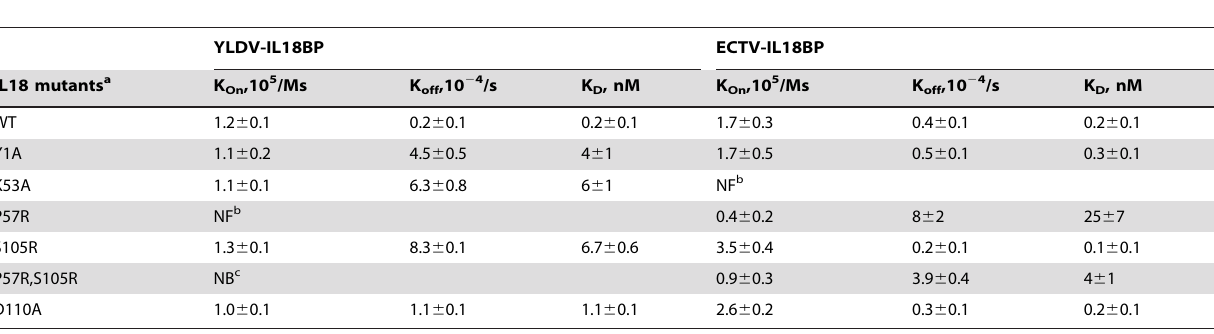
Table 3. Kinetics and affinity constants of the binding of IL18 mutants with immobilized IL18BPs.